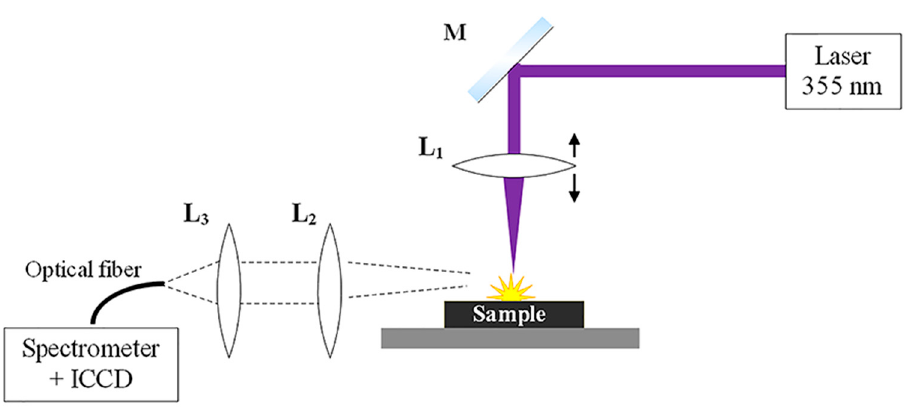
Figure 1. Schematic diagram of the laser ablation experiment.